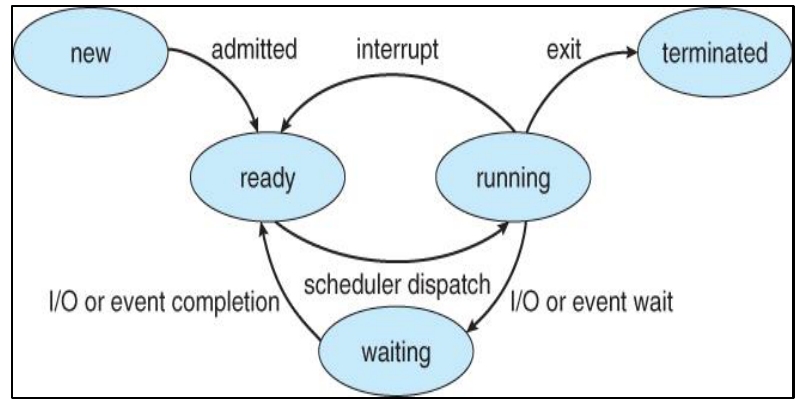
Figure 1. Basic CPU